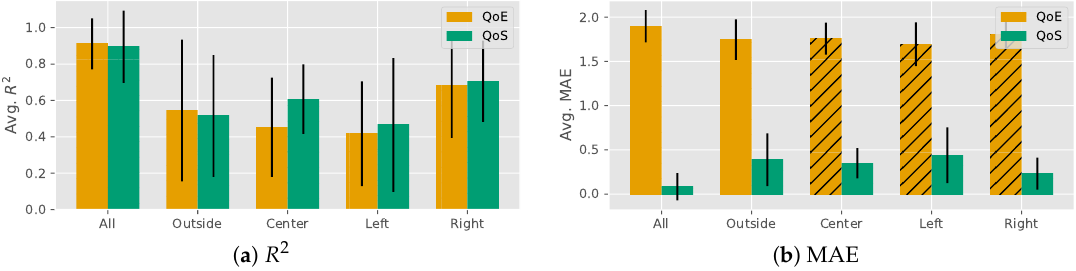
Figure 5. Overview of the EEGz results for individual users and electrode positions for the QoE/QoS predictions based on